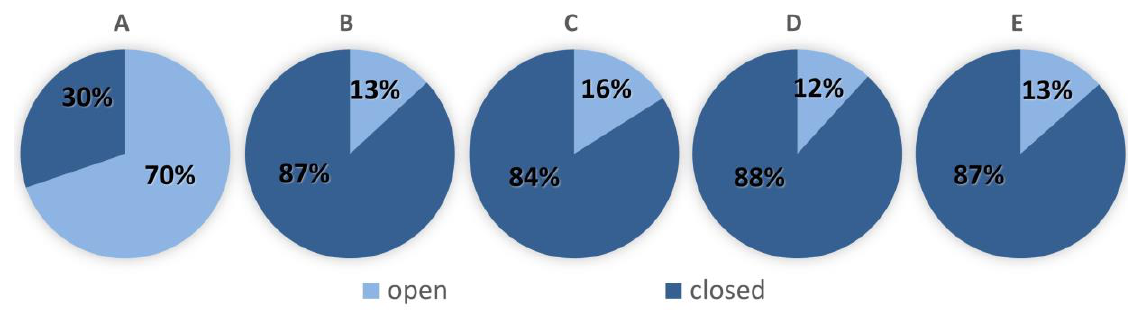
Fig. 5. Number of water bodies by their hydrological type (A – the beginning of the 19 th century, B – the end of the 19 th century, C – the beginning of the 20 th century, D the end of the 20 th century, E ¬ the beginning of the 21 st century; own study based on databases)